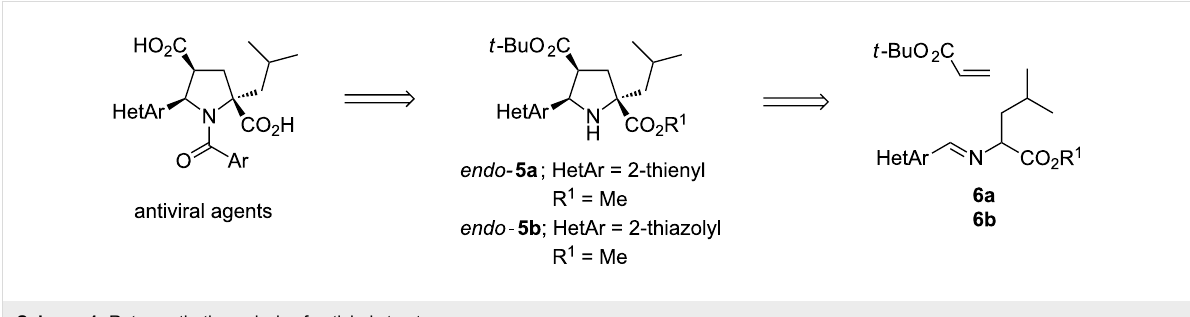
Scheme 1: Retrosynthetic analysis of antiviral structures.